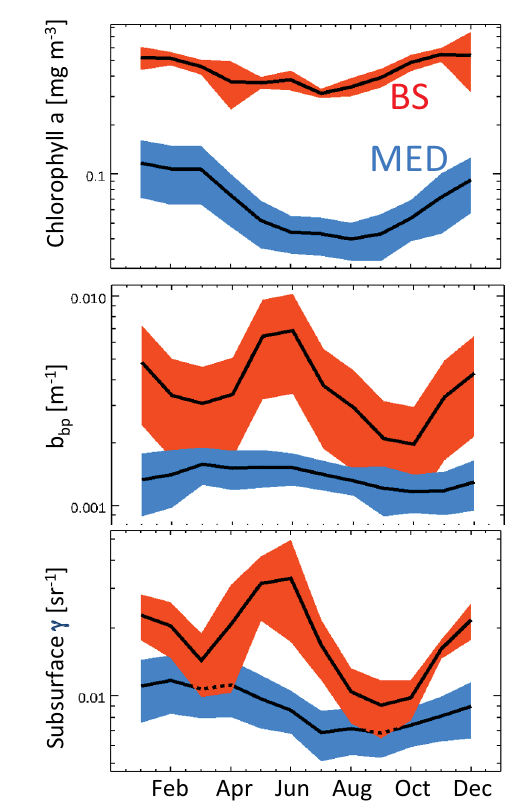
Figure 2. Mean annual cycles and the associated standard deviation of Chl-a, b bp and γ (high, central and low panels, respectively) for MED and BS (blue and red